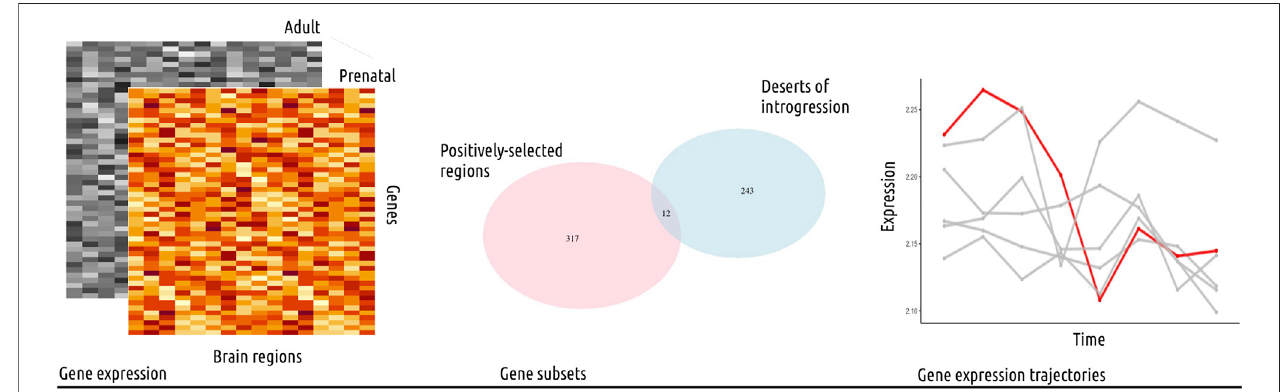
FIGURE 1 | Study outline. In this study, we used publicly available gene expression data from the psychENCODE project (Li et al., 2018), covering sixteen brain regions and eight developmental stages, from prenatal to adult (left panel). The data was analyzed following standard procedures and the normalized, log-transformed gene expression values were then used for further analysis. We focused on gene subsets from genomic regions with evolutionary-relevant properties (middle panel): 1) positively-selected regions and 2) large deserts of introgression (see also Table 1 ). We investigated the expression trajectories of genes ful fi lling both of these conditions (twelvegenes intotal) across brainregions, and proceeded tocompare their geneexpression valuestocontrolgenesfrom length and genedensity-matched random regions, as well as to other subsets of genes. Speci fi cally, we performed a Principal Component Analysis and calculated the Euclidean distance between each data point (gene expression value for a subset of genes in a particular brain region) per developmental stage to identify statistically signi fi cant differences (Wilcoxon rank sum test with Bonferroni correction) among brain regions. This analysis was complemented with a segmented regression model for a single-gene analysis of gene expression dynamics (right panel). Collectively, we found the most signi fi cant differences for the cerebellum, the striatum and the mediodorsal nucleus of the thalamus.